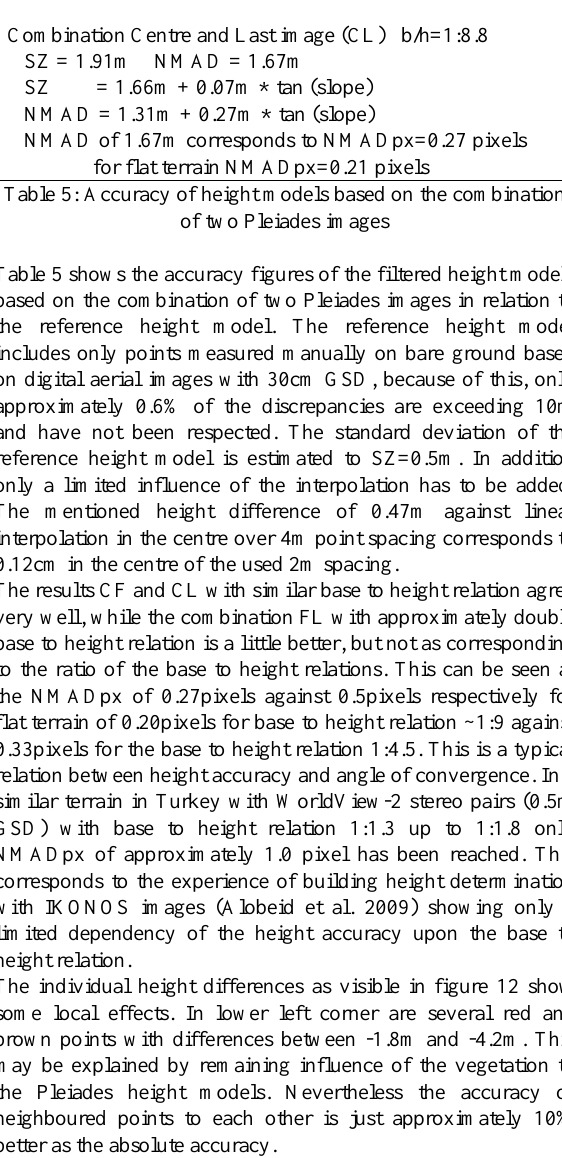
Figure 13. Colour coded height differences of the DSM based on all 3 images against